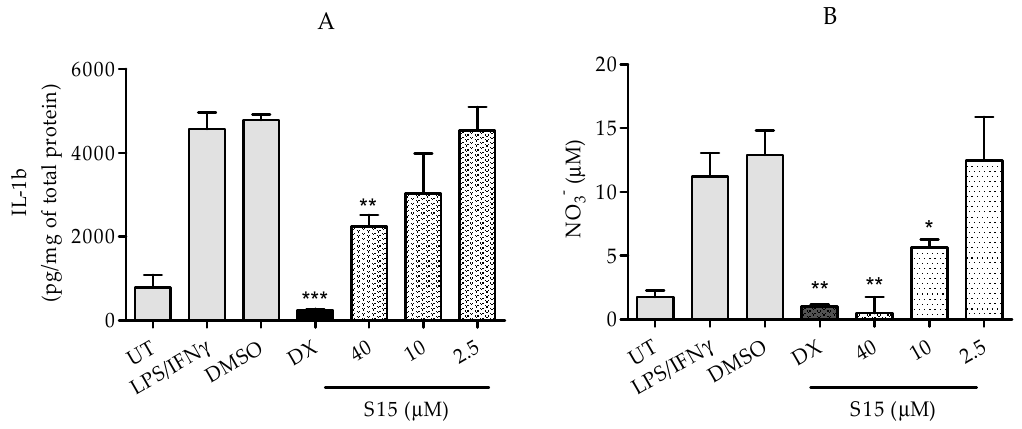
Figure 3. In vitro anti-inflammatory activity of the S15 derivative in activated primary microglia. Microglia-enriched primary cultures were obtained from brains of adult male rats. Different concentrations of the S15 derivative, solvent control (DMSO) or 10 µM of dexamethasone (DX) as the positive control of inhibition were applied to some microglia cultures, 30 min before the activation of microglia cells with lipopolysaccharide (LPS, 1 µg/mL) and murine recombinant interferon gamma (IFN γ , 20 U/mL). Untreated (UT) microglia cells were included as the negative control of inhibition. After 24 h of exposition or not to the stimulus and treatment, the IL-1 β level was quantified by ELISA ( A ), and the content of nitrite was determined by the Griess assay ( B ). Asterisks indicate statistical differences between the treatment and respective control condition (* p < 0.05, ** p < 0.01 and *** p < 0.001) according to one-way ANOVA and Tukey’s post-hoc test.